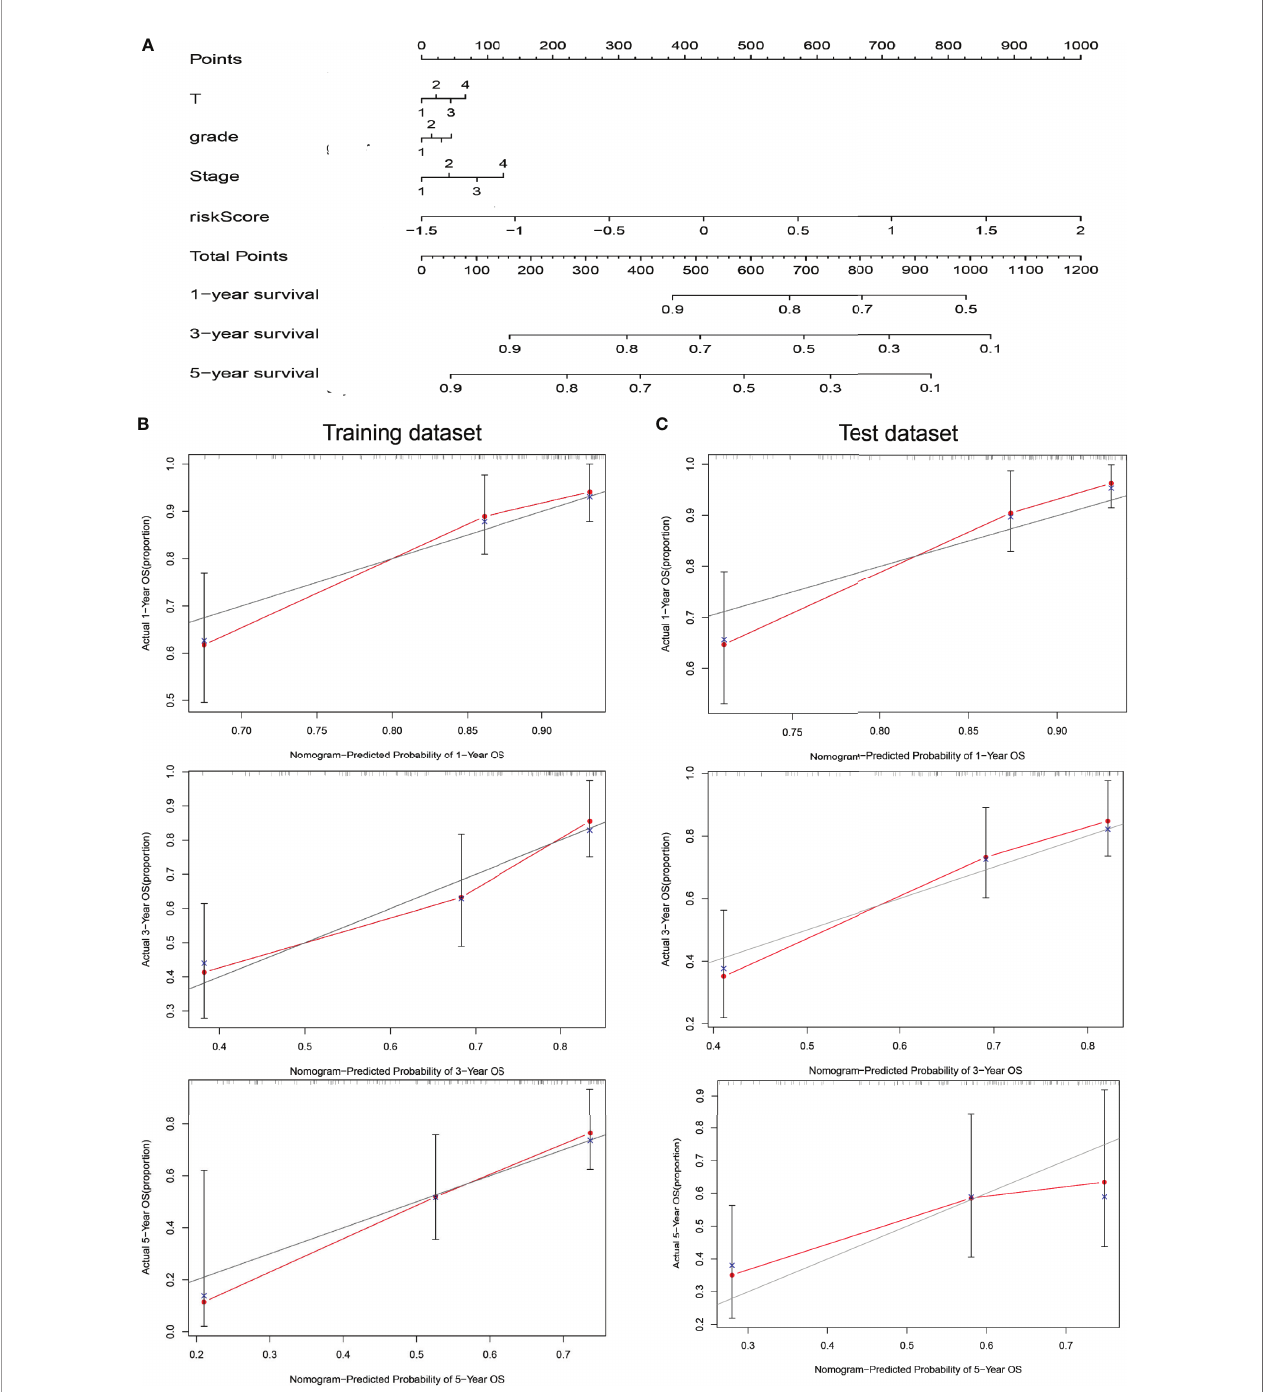
FIGURE 4 | A nomogram combining risk score and clinical features evaluated survival in HCC. (A) Nomogram for predicting OS. Description: position each feature point on the corresponding variable axis, draw a vertical line upward to the point axis, and determine the value of the speci fi c point. Repeat the process. Calculate the total score and position it on the total axis. Draw a vertical line down to the one-, three- and fi ve- year OS to obtain the survival probability of speci fi c liver cancer patients. (B) The calibration curve of the nomogram for one, three, and fi ve years of OS prediction in the training dataset. (C) The calibration curve of the nomogram for one, three, and fi ve years of OS prediction in the test